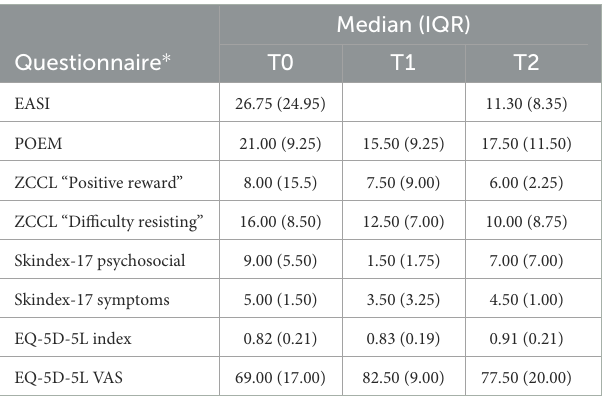
TABLE 2 Explorative analysis decease activity, quality of life and